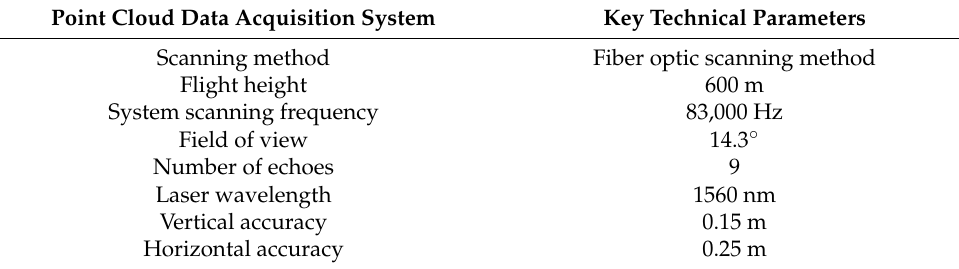
Table 4. Key technical parameters of point cloud data acquisition system.